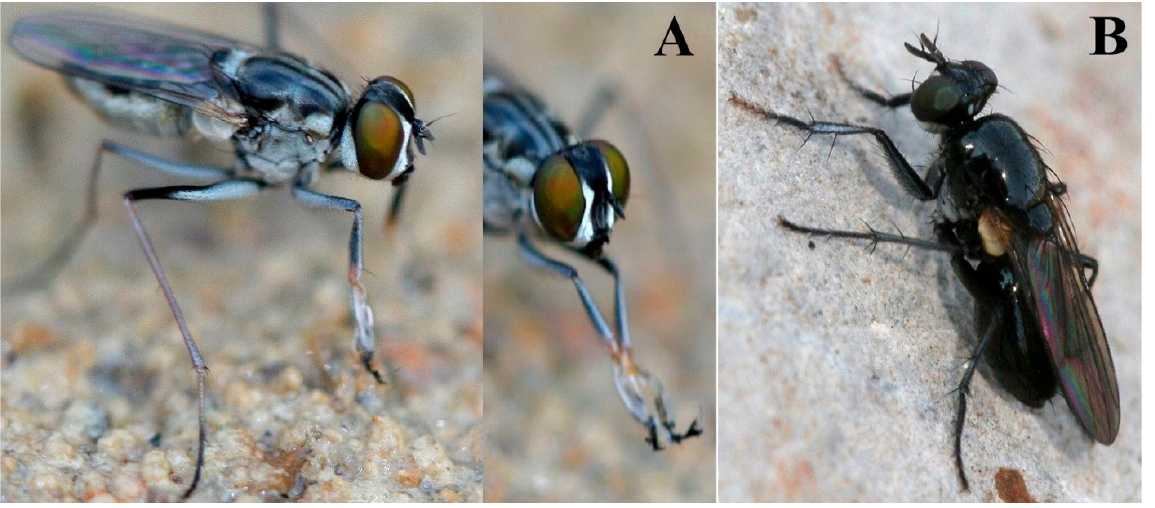
Figure 3. ( A ). L. mirabilis Stein, 1918, male, Thailand; ( B ). L. kowarzi kowarzi Becker, 1903, female, Turkey (photo: N. Vikhrev).